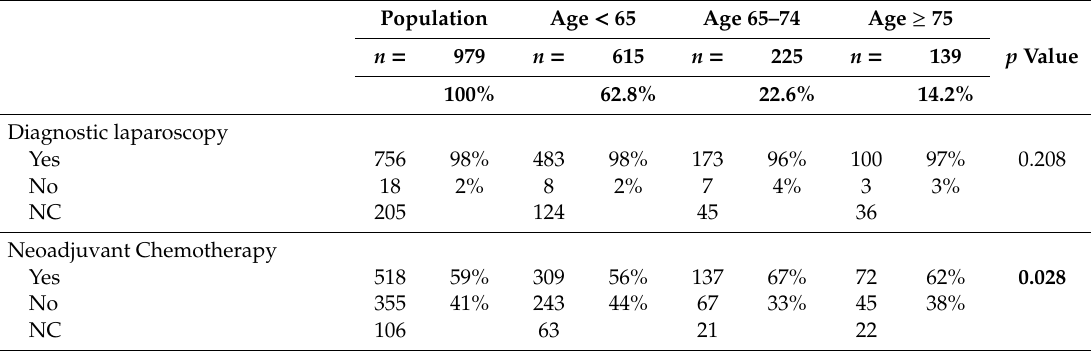
Table 2. Treatment